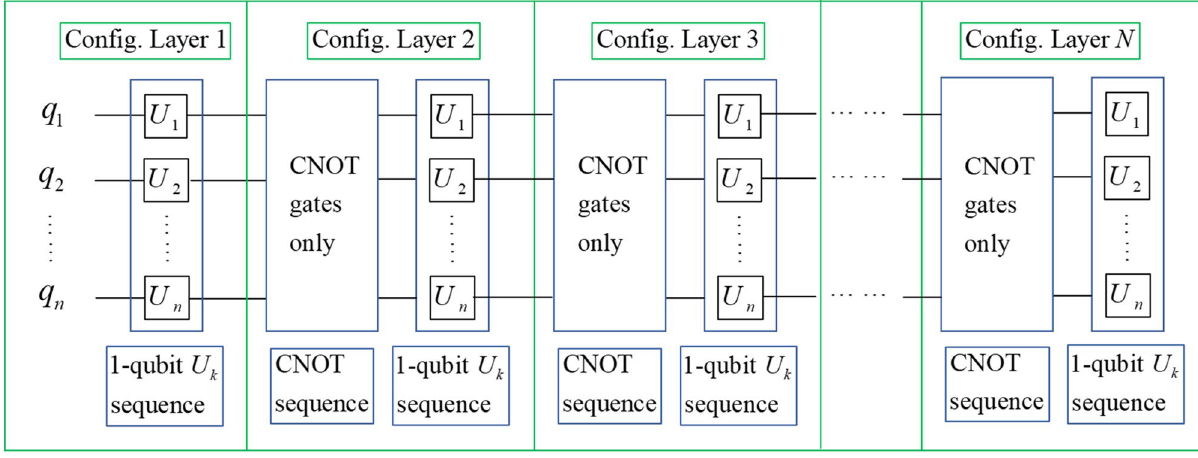
th qubit”, thus U k is